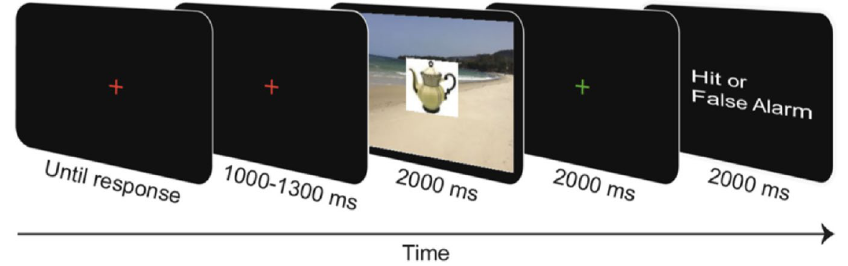
Figure 6. Trial sequence of Experiment 2 (ERP experiment). Note that the last frame, “Hit or False Alarm” was only presented if a key was pressed in the response window of the RDT (indicated by the green fixation